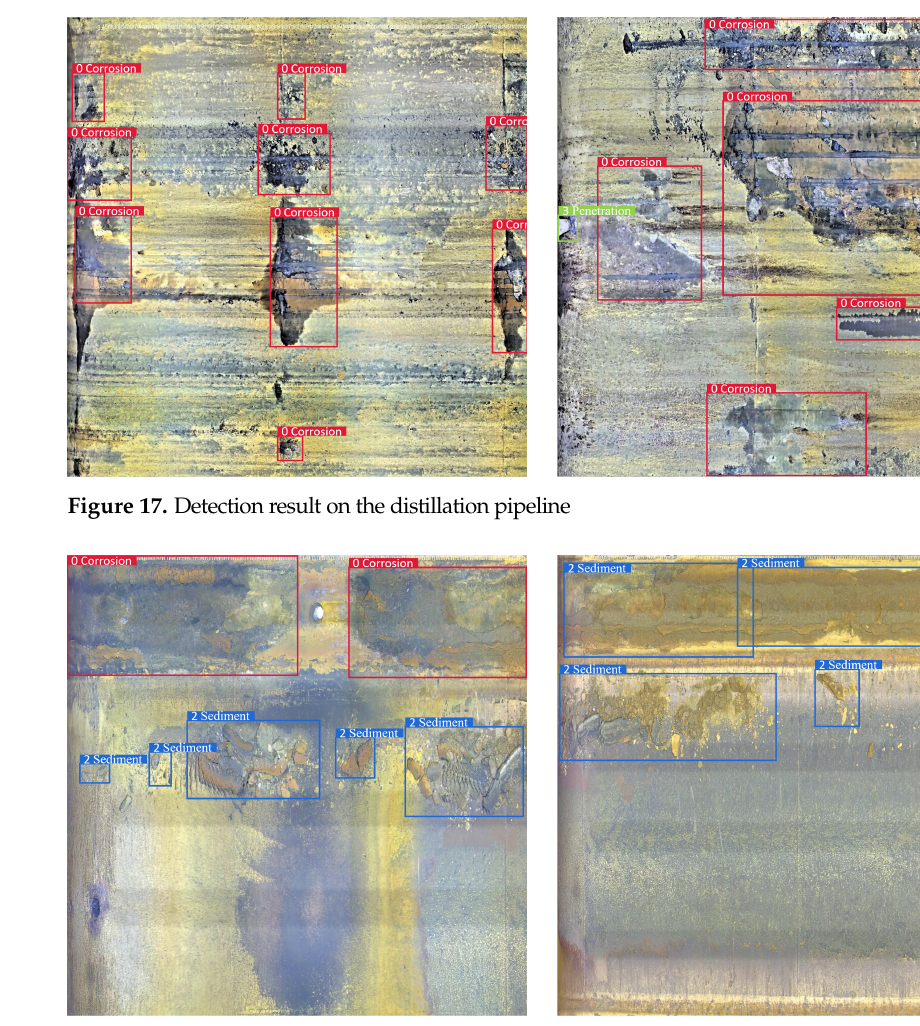
Figure 18. Detection result on the catalytic